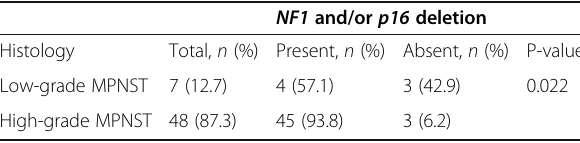
MPNST malignant peripheral nerve sheath tumor, NF1 neurofibromatosis